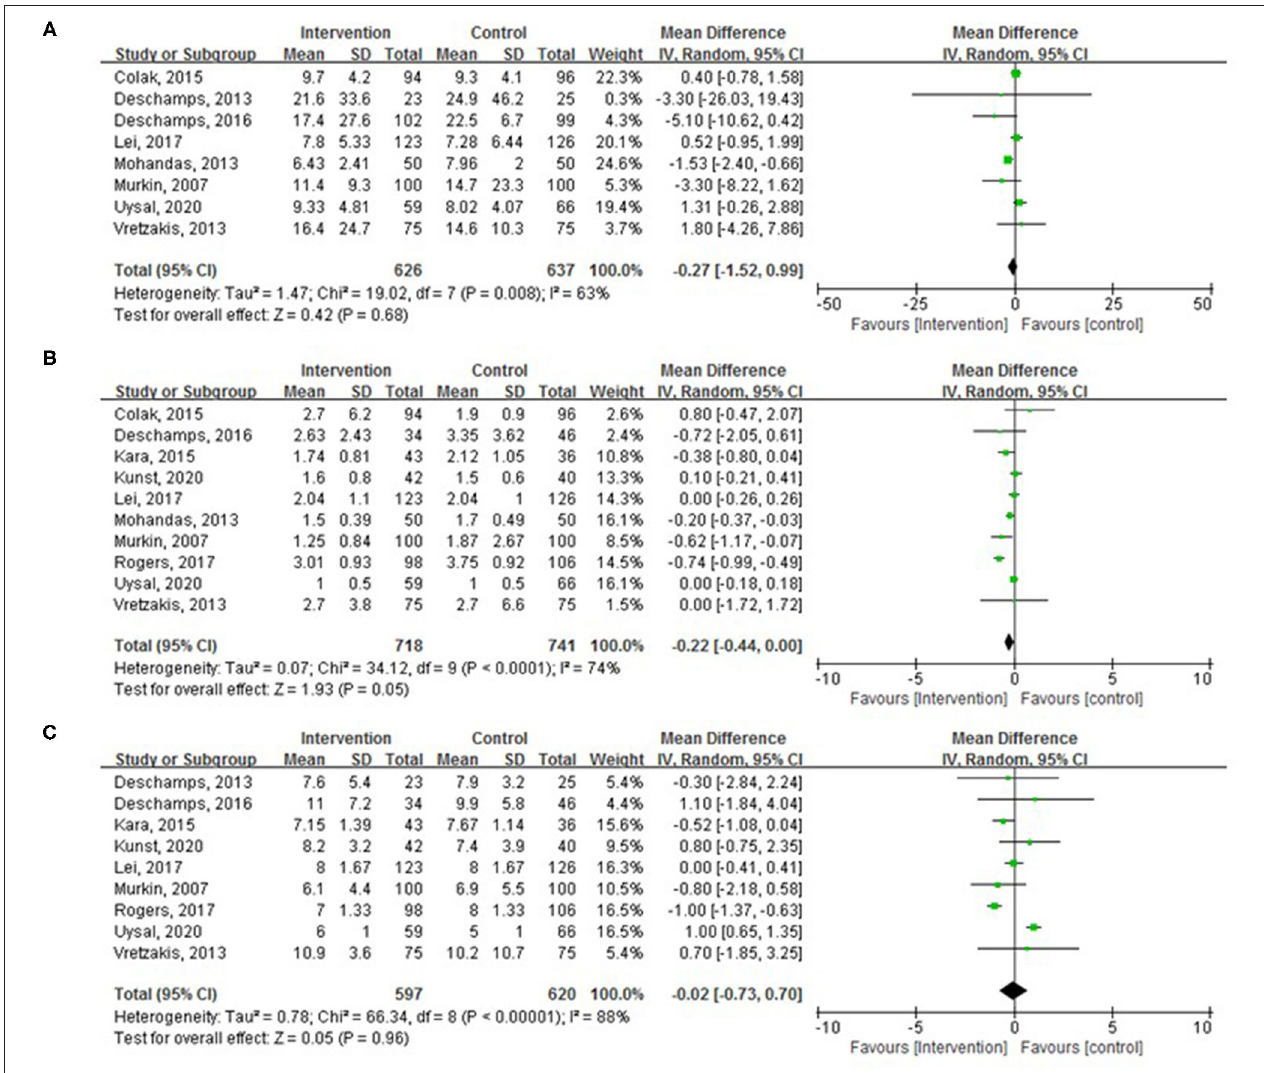
FIGURE 5 | Pooled effect of cerebral oximetry monitoring guided intervention on (A) mechanical ventilation duration, (B) intensive care unit (ICU) length of stay (LOS), and (C) length of postoperative hospital stay.